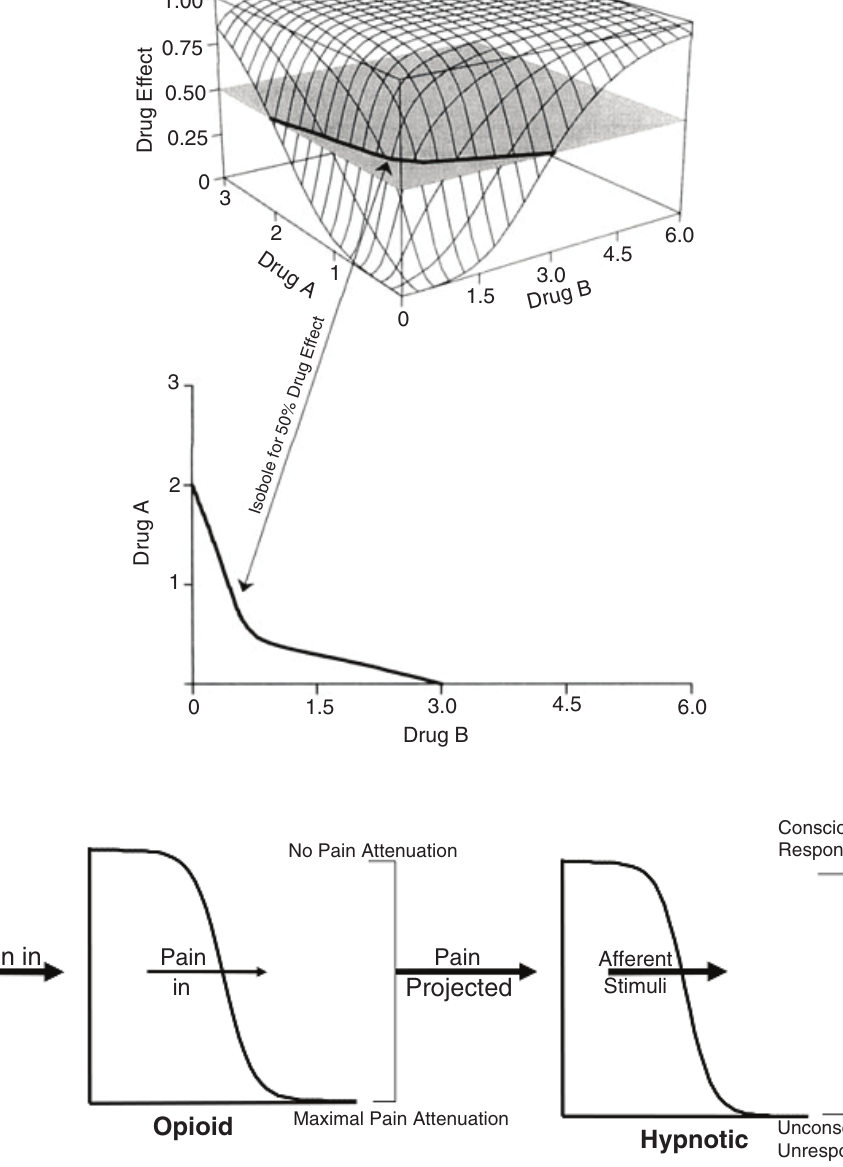
Figure 3. Drug interaction approaches. (Top) Minto response surface. (Bottom) Bouillon indirect